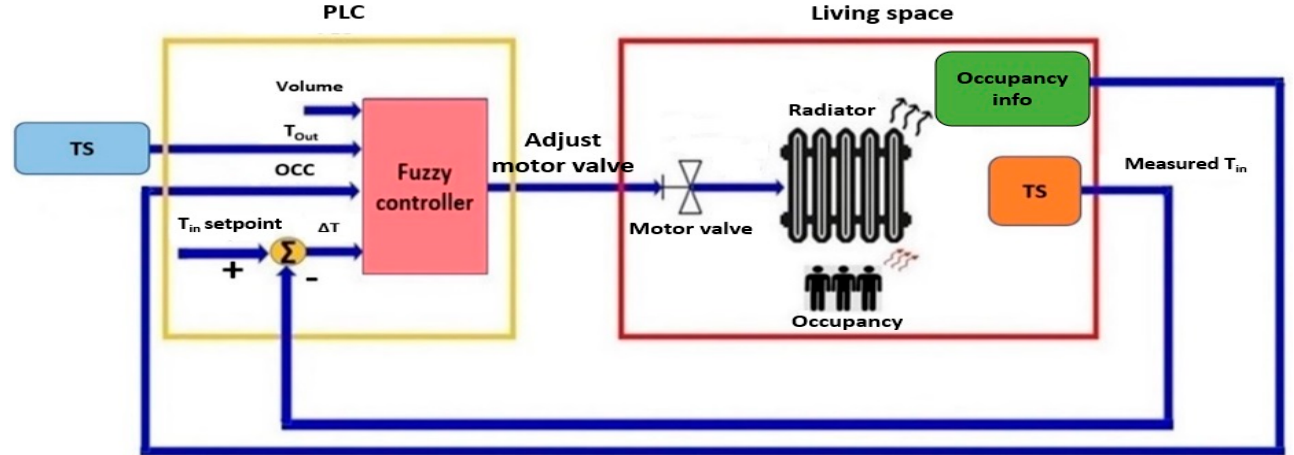
Figure 5. Block diagram of the neuro-fuzzy model where the Fuzzy controller in a feedback loop controls the temperature of the living space (neuro part). TS: temperature sensor; T: temperature, OCC: occupation, PLC: programmable logic controller.